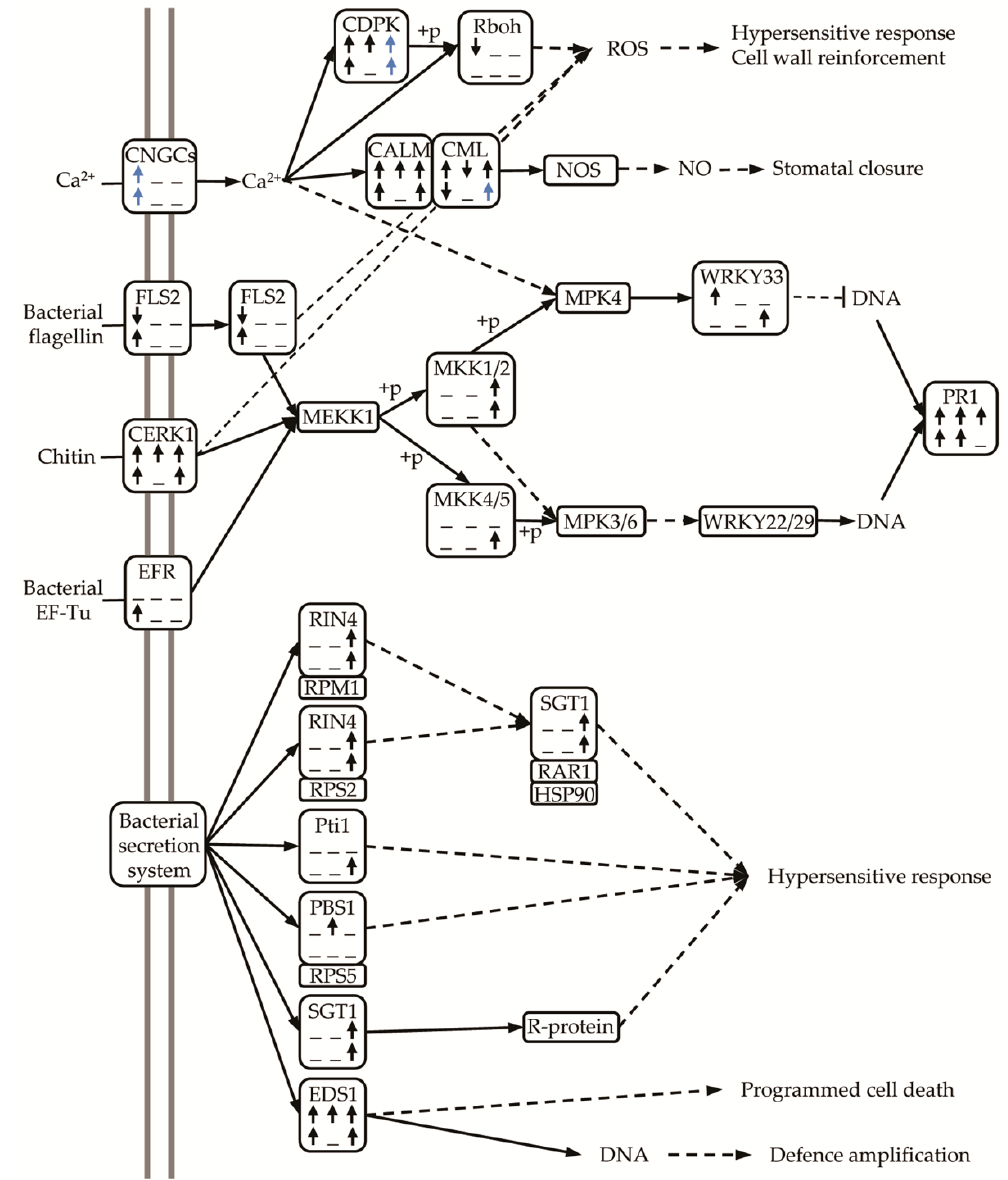
Figure 7. Plant-pathogen interaction pathway. The results are based on KEGG KASS analysis [37] of all DEGs identified in microarray and RNA-seq. Arrows indicate that all or most (blue arrow) DEGs encoding the particular pathway component are up- or down-regulated. DEGs from PSTVd-M and PSTVd-S23 infections are presented in the first and the second row, respectively.